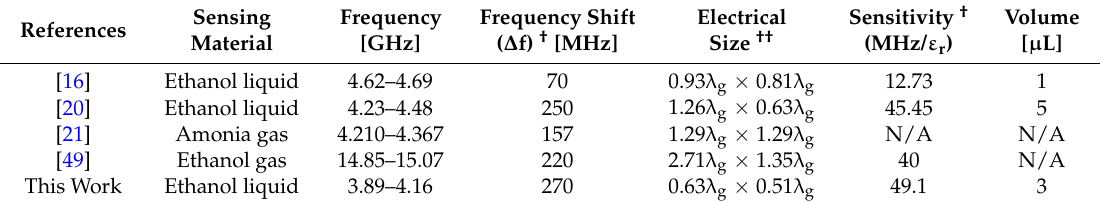
Table 2. Comparison table of proposed sensor and other RF sensors.